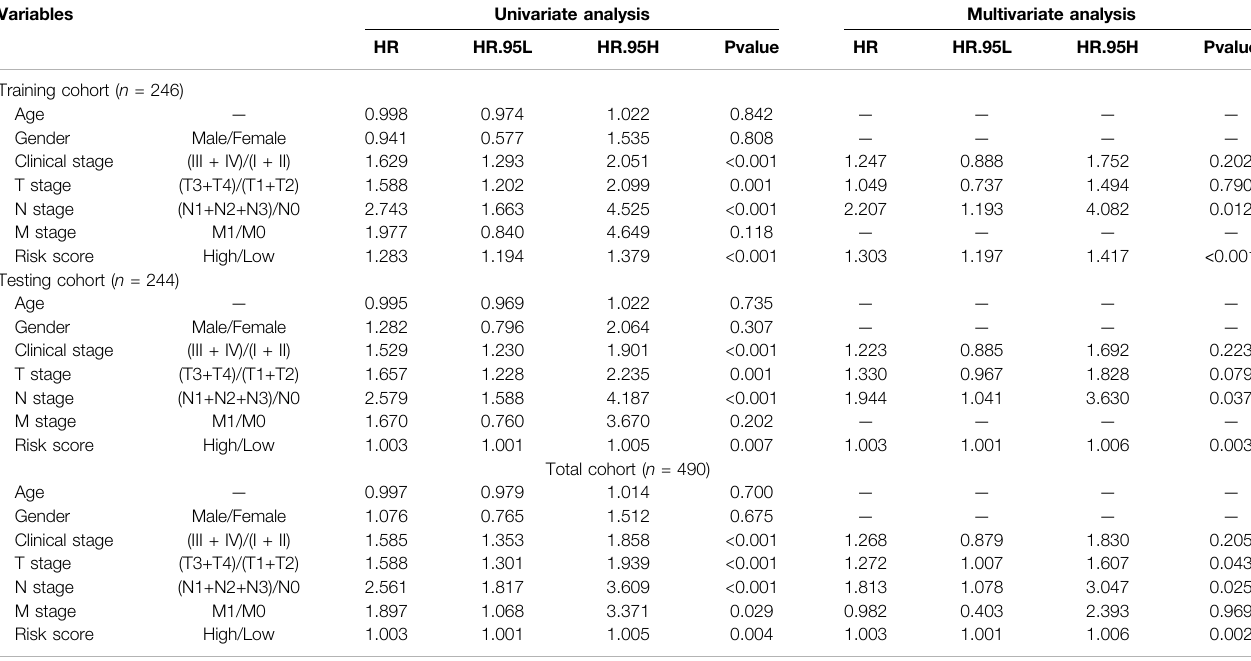
TABLE 2 | Univariate and multivariate analyses of risk factors associated with the prognosis of LUAC patients.